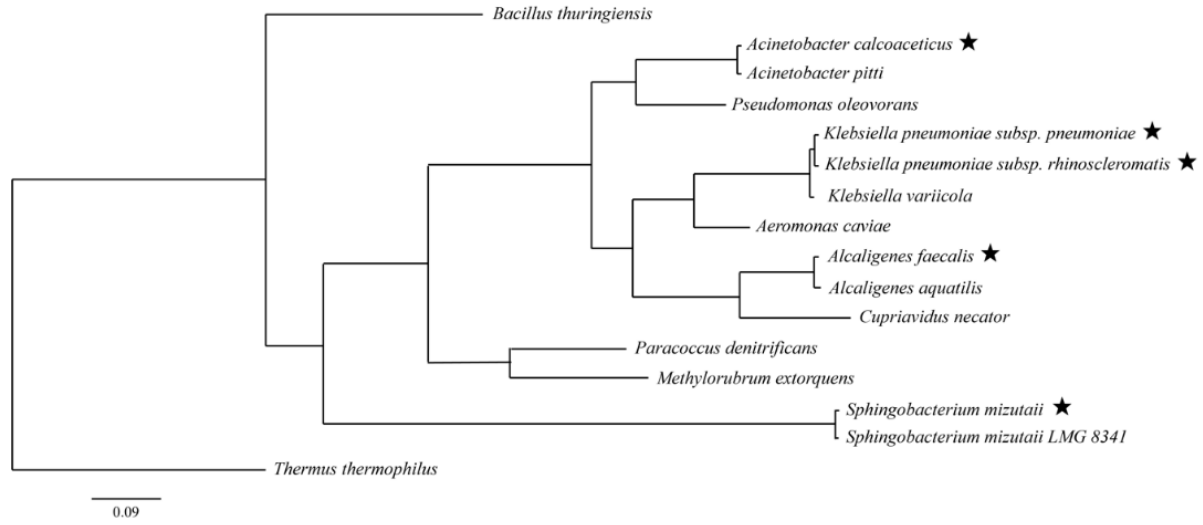
Figure 2. Phylogenetic tree constructed using Bayesian inference strategy and fig tree demonstrating the relations between the isolated strains ( ★ ) and other related species.